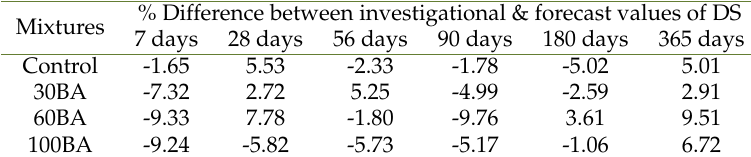
6. Green concrete comprising 30%BA indicated better and predominant execution in terms of strength and DS which commented on its application in structural concrete with the design strength of 30 MPa.